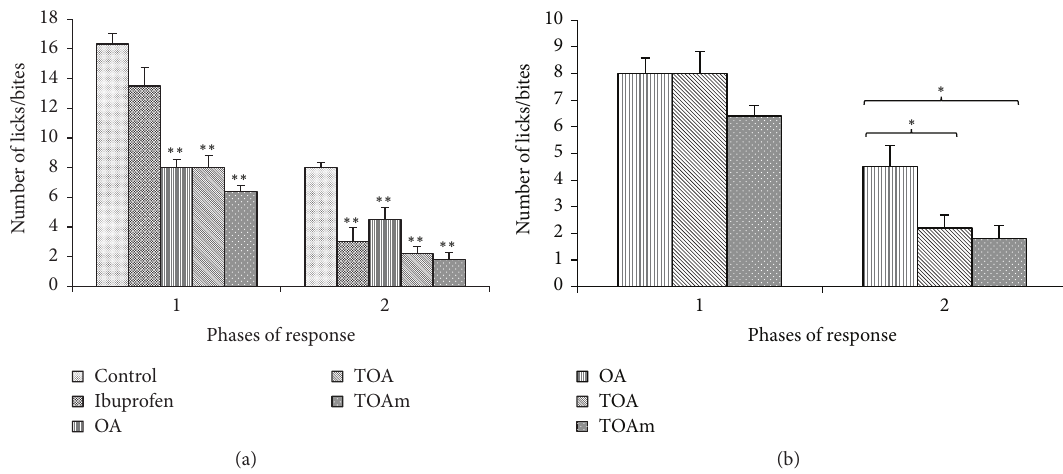
Figure 5: Formalin-induced pain behavior. OA (oleanolic acid), TOA (3-trifluoroacetyloleanolic acid), and TOAm (28-methylester, 3- trifluoroacetyloleanane). Results are presented as mean number of licks/bites ± SEM for 6 animals; ∗ 𝑝 < 0.05 and ∗∗ 𝑝 < 0.01 . (a) shows a comparison of the tested compounds with control group, whereas (b) displays a comparison of the trifluoroacetyl derivatives with OA.